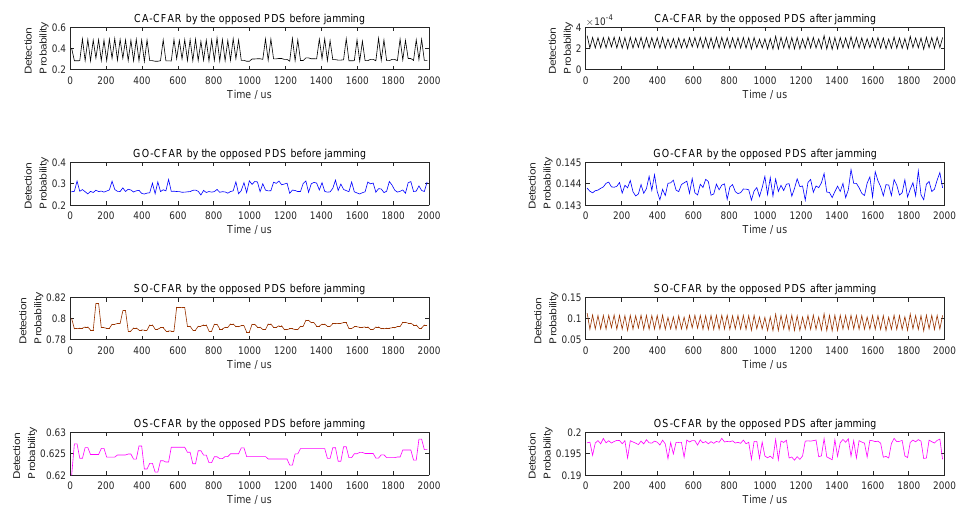
Figure 5. Detection probability of CA, GO, SO, and OS-CFAR before and after jamming when the number of reference units is 12.